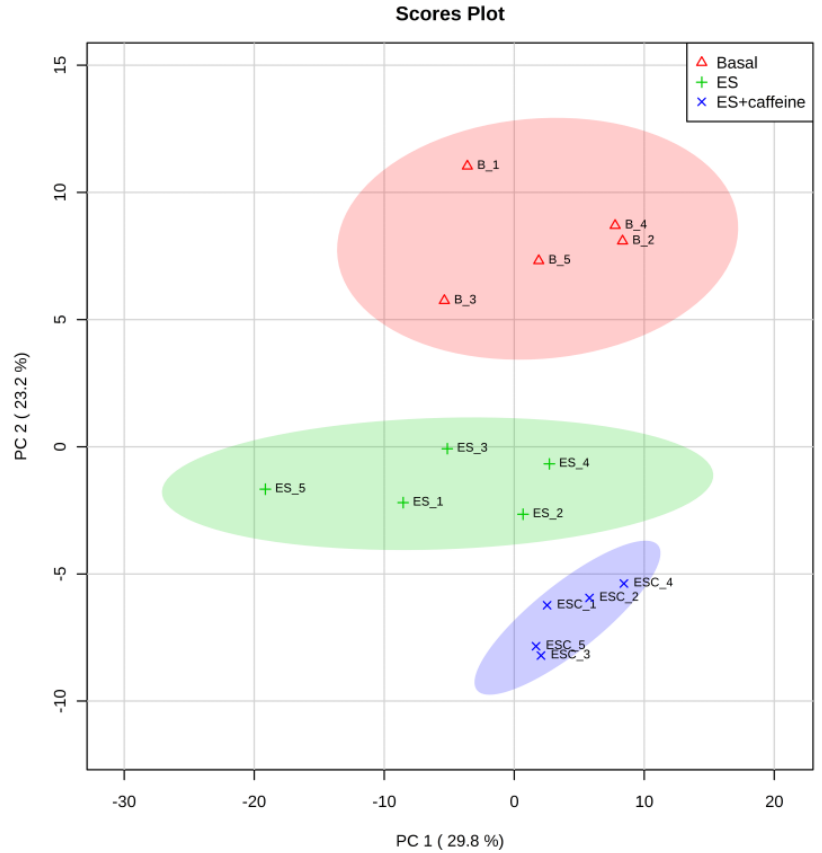
Figure 1. Principal component analysis (PCA) plot of the identified metabolites of the skeletal muscle of three groups, basal (B), electrical stimulation (ES), and electrical stimulation + caffeine (ESC). Principal components (PC1 and PC2) capture 53.0% of the variation in the dataset. The elliptic areas represent the 95% confidence regions.